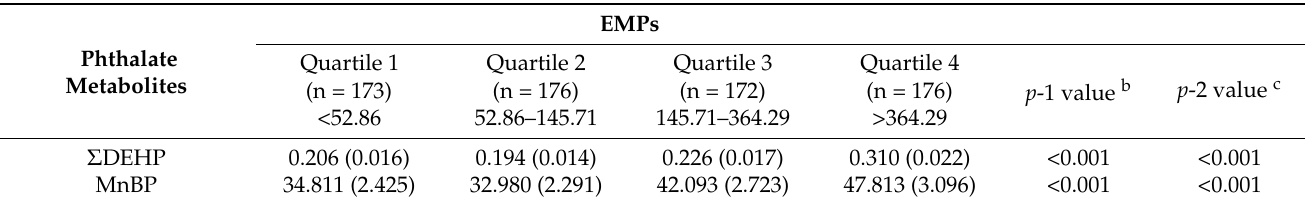
Table 3. Geometric means and standard errors of creatinine-adjusted urinary concentration of Σ DEHP and MnBP by quartile distribution of EMPs and PMPs a